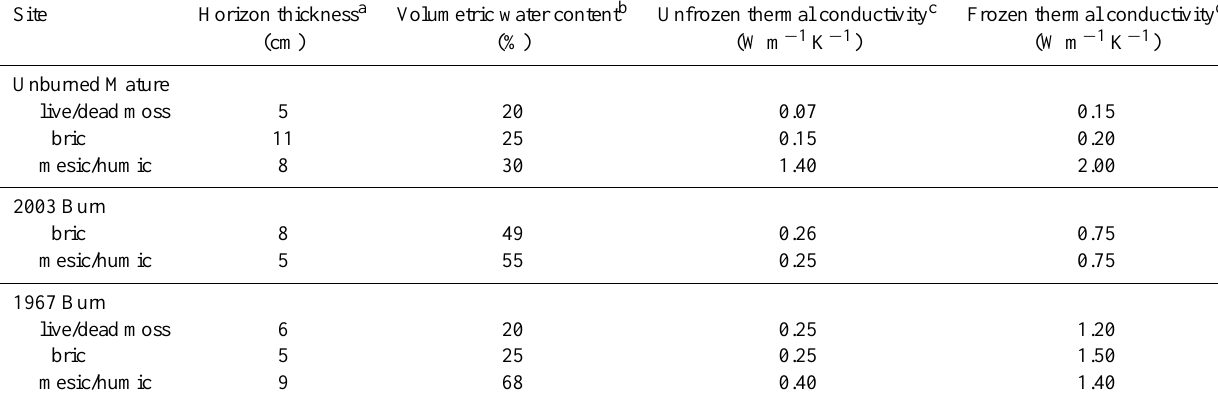
Table 3. GIPL model parameterizations at three study sites across fire chronosequence at Hess Creek,